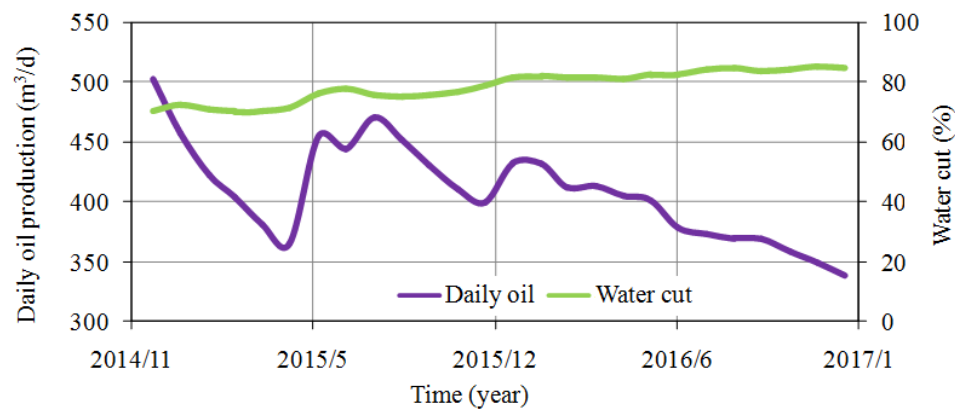
Figure 3. The daily oil production and water cut change law of new wells.